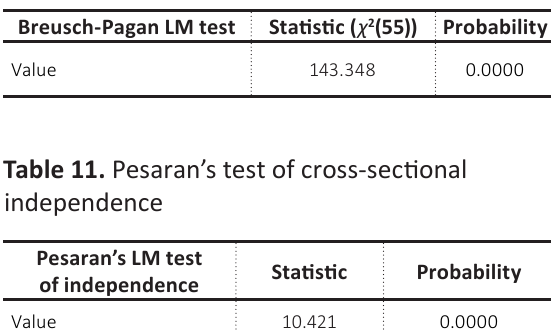
Table 10. Breusch-Pagan LM test of cross- sectional independence